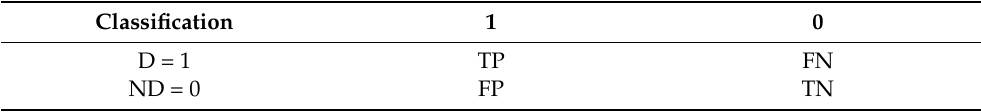
Table 4. Confusion matrix of demented